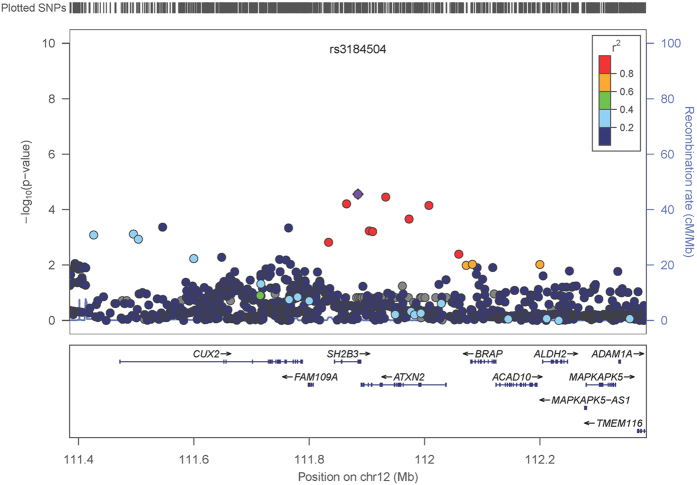
Regional association plot for region around rs3184504.Plots are produced in LocusZoom and show the most strongly associated SNP, rs3184504 (purple diamond). rs7137828, intron of ATXN2, is the SNP with the second lowest P value. The primary aim of this analysis is to compare association signals among SNPs in the region. Therefore, the data are derived from a meta-analysis of genotyped or high-quality imputed SNPs in the GWAS data sets, and because imputation quality was more variable in iCOGS than in the GWAS data, the iCOGS samples are not included.